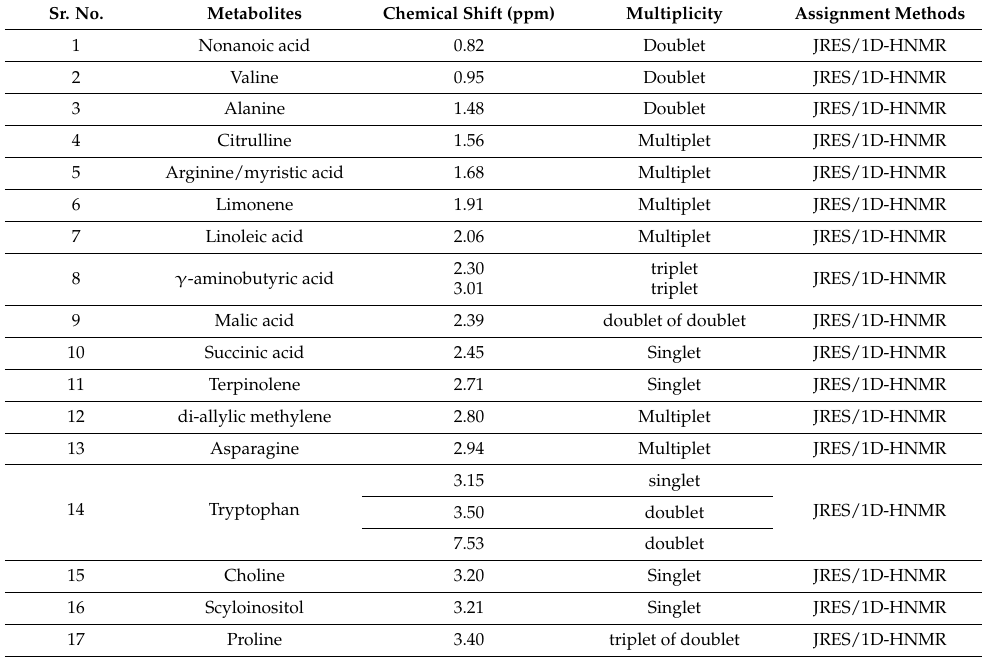
Table 1. List of identified metabolites from G. hirsutum . Sr.